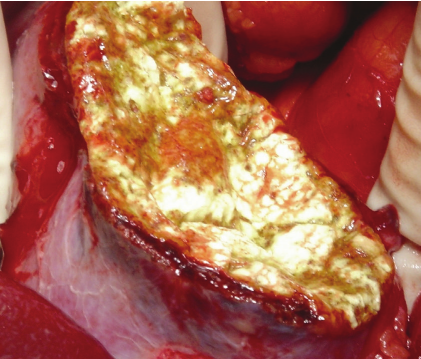
Figure 3: Open partial nephrectomy for renal cell carcinoma of inferior pole satisfactory hemostasis with application of a fibrinogen hemostatic patch (Tachosil, Nycomed Pharma,